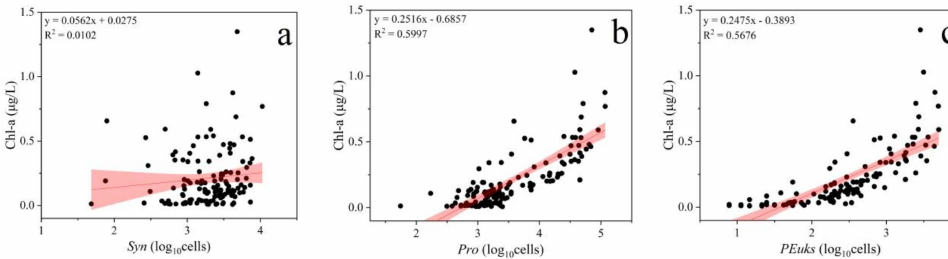
Figure 10. Comparison of the results between chlorophyll and the concentration and cell abundances of pico. ( a ) Synechococcus ( Syn ), ( b ) Prochlorococcus ( Pro ), ( c ) Picoeukaryotes ( PEuks